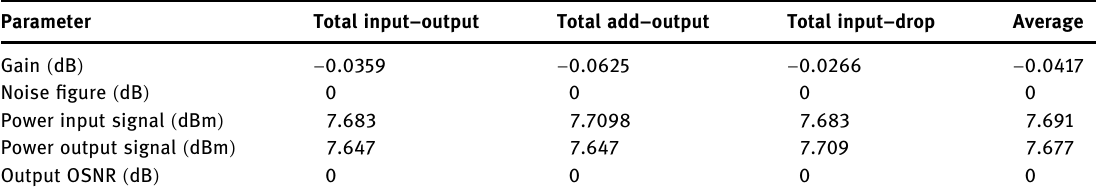
Table 4: The total ratio for the input, output, and drop signals calculated by dual port WDM analyzer